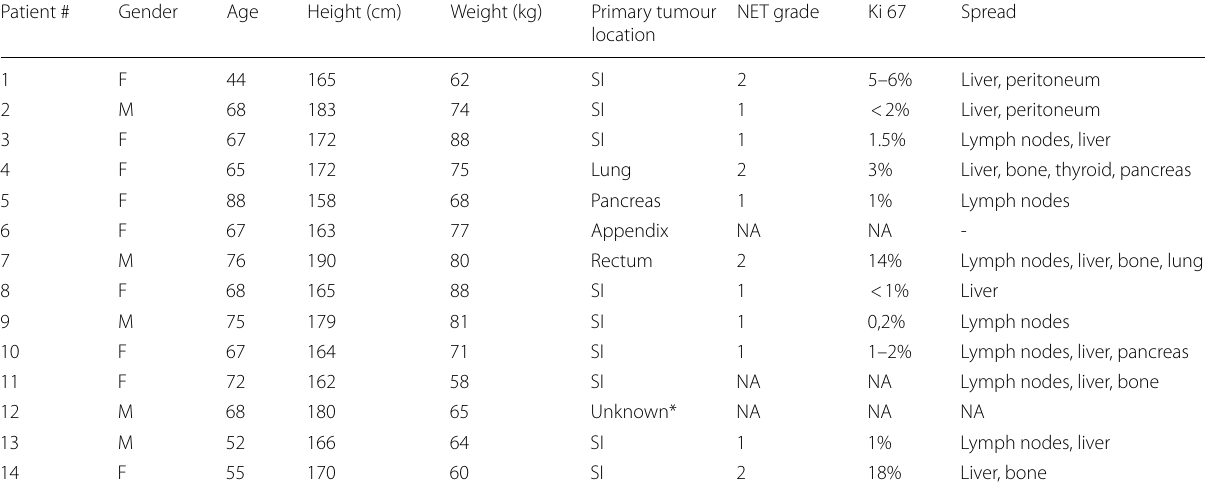
M male, F female, NET neuroendocrine tumour, SI small intestine, NA not available; *NET with unknown primary location